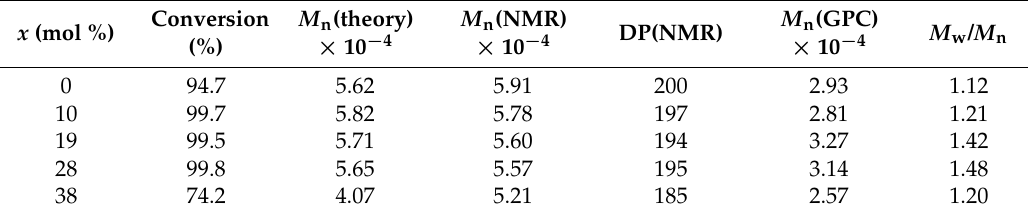
Table 1. Conversion, Number-Average Molecular Weight ( M n ), Degree of Polymerization (DP), and Molecular Weight Distribution ( M w / M n ) of P(MPC/DMA x